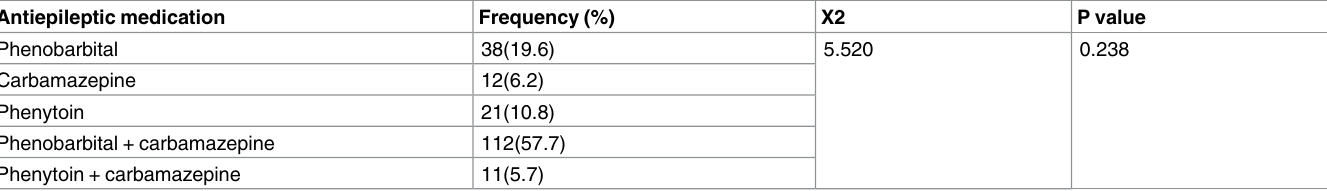
Table 2. Antiepileptic medications prescribed to treat epilepsy at Yirgalem General Hospital.